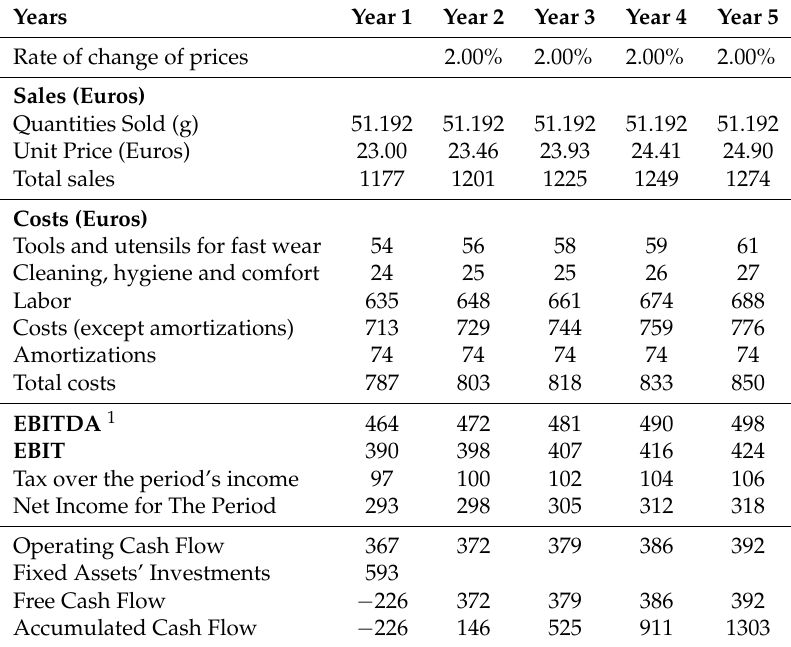
Table 9. Intensive Collector.